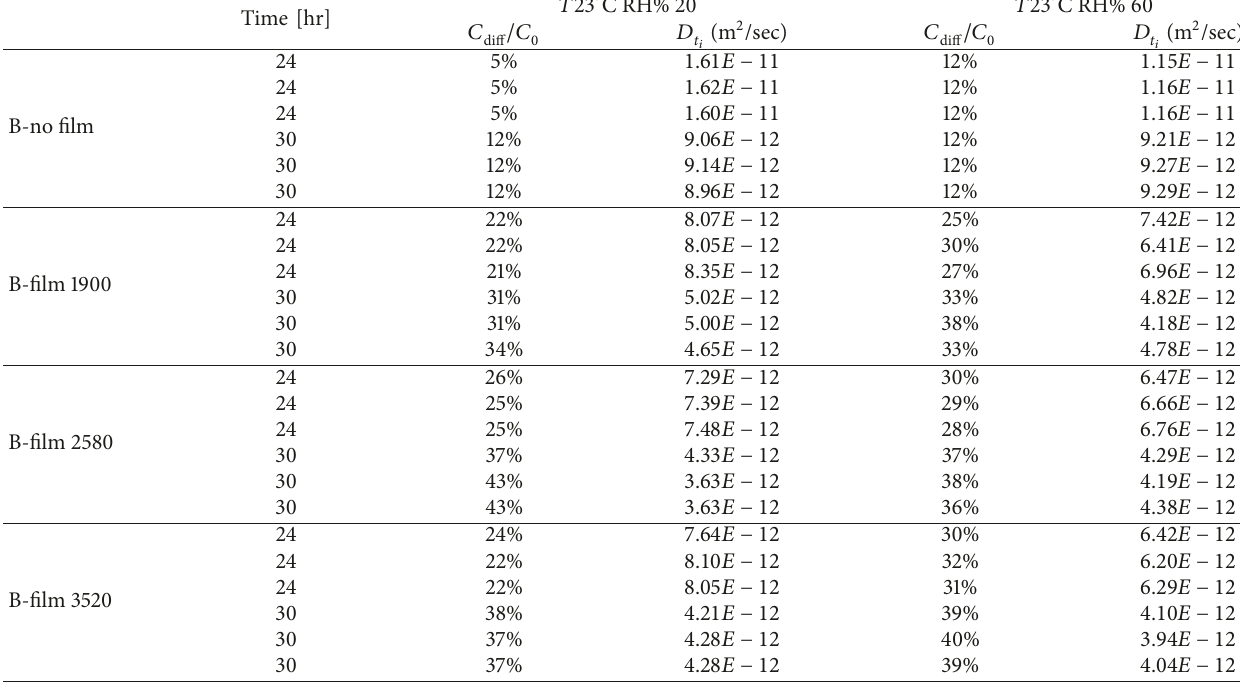
Table 5: Diffusioncoefficient of H 2 Sover timeina Nalophan bag storedat a temperatureof23 ∘ Cand ahumidity of20% and 60%, respectively. The bag tested was without any film inside (B-no film) and with the film inside. The surface of the internal film sheet was equal to 1900 cm 2 (B-film 1900), 2580 cm 2 (B-film 2580), and 3520 cm 2 (B-film 3520),